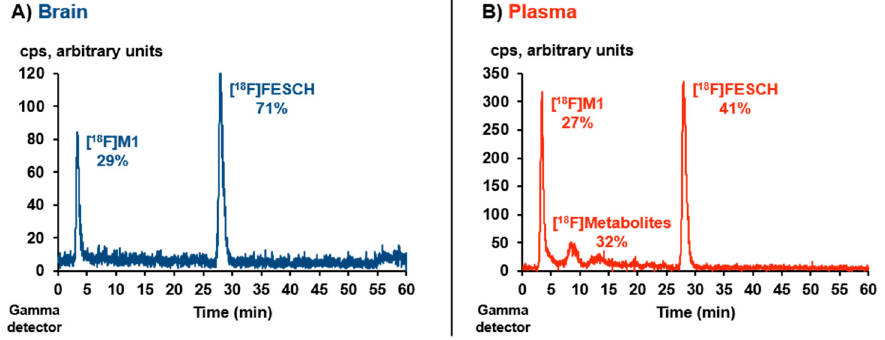
Figure 5. Representative in vivo metabolism study of CD-1 mouse plasma and brain samples at 15 min p.i. of [ 18 F] FESCH (~ 17 MBq): Analytical radio-HPLC profiles of extracted ( A ) brain and ( B ) plasma sample (column: Reprosil-Pur 120 C18-AQ, 250 × 4.6 mm, particle size: 5 µ m; eluent: 26-90-26% MeCN/20 mM NH 4 OAc aq. , flow: 1 mL/min).